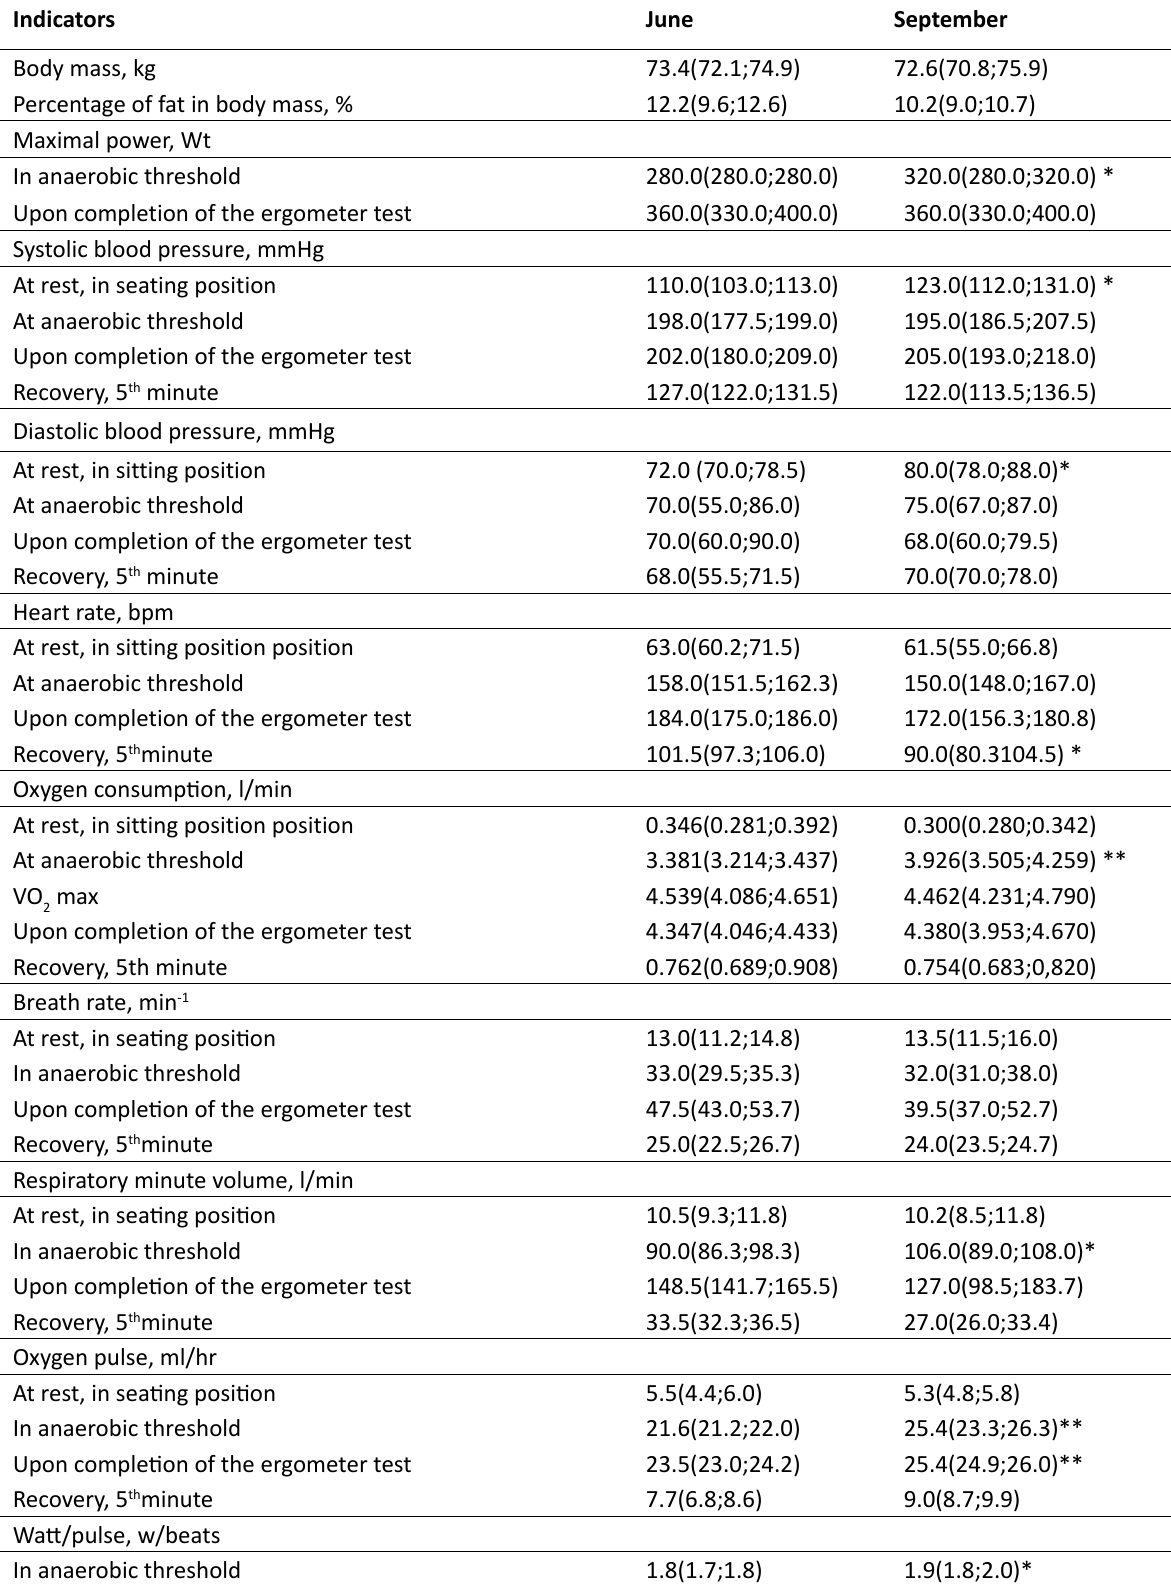
Table 2. Physiological and biochemical parameters of ski runners at the beginning and at the end of the training period